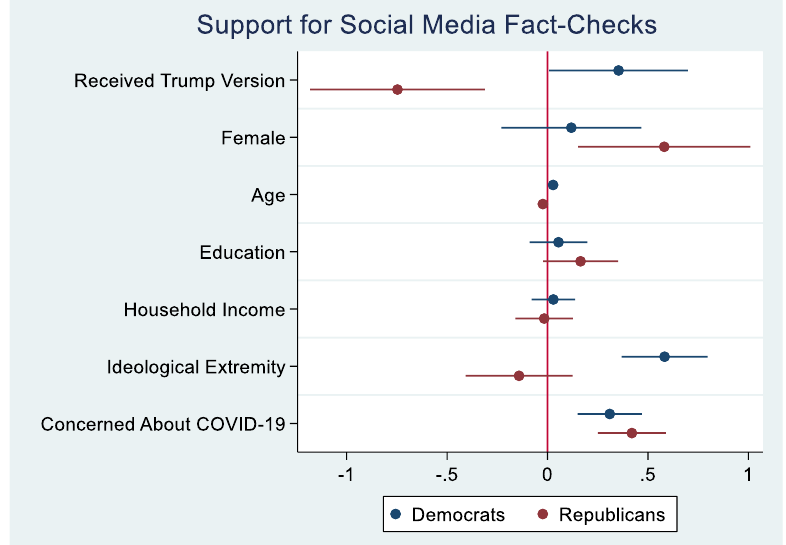
Figure 3. Coefficients of support for social media fact-checks among Democrats and